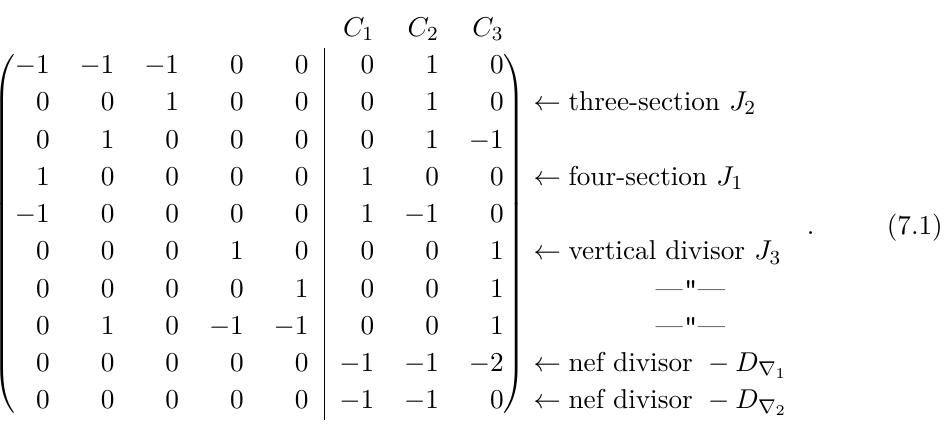
figure 8. The classes of the divisors that determine the nef partition are given in the last two rows of